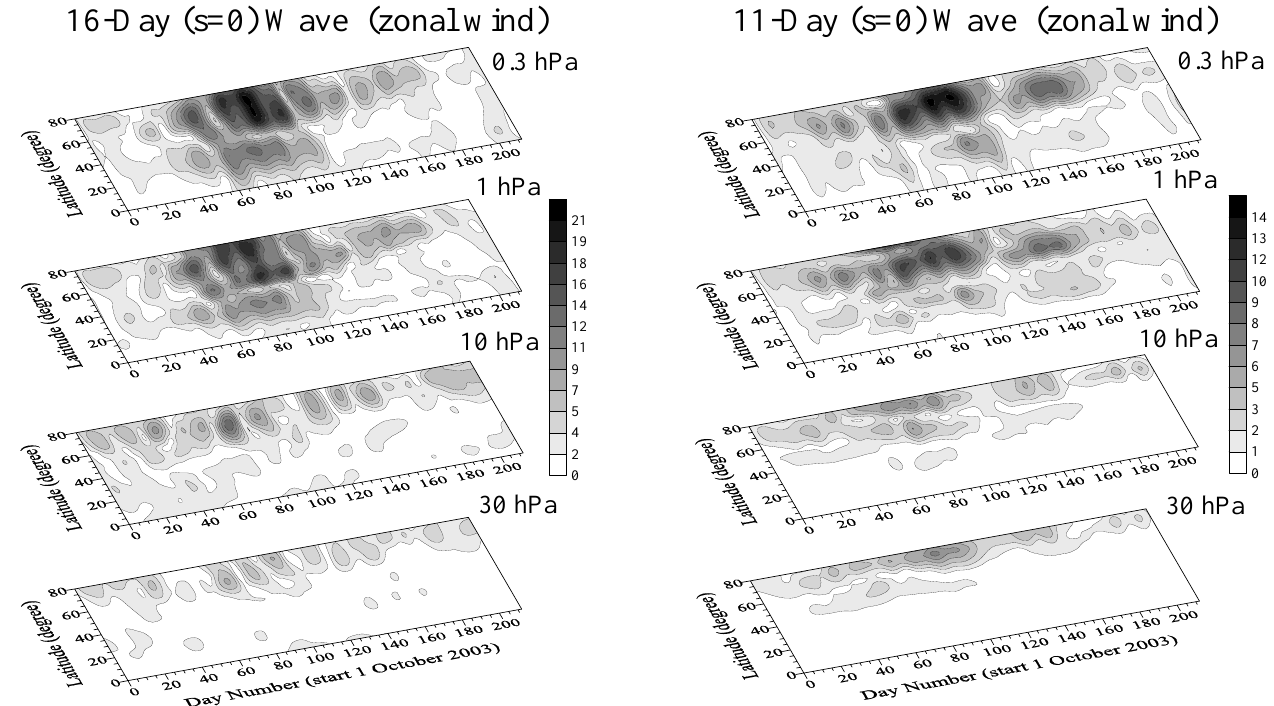
Figure 3 Fig. 3. Latitude-time cross sections of the amplitudes of ∼ 16- (left column of plots) and ∼ 11-day (right column of plots) zonally